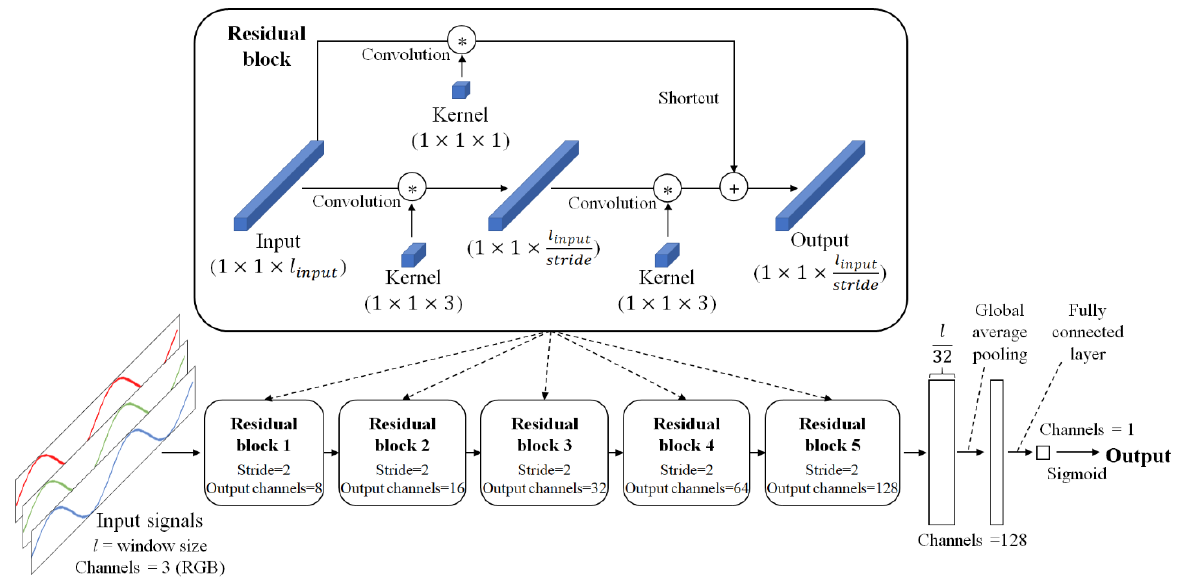
Figure 2. Structure of the ROI detection model. The variance in pixels is the input and the probability that the variance is related to respiration is the output.